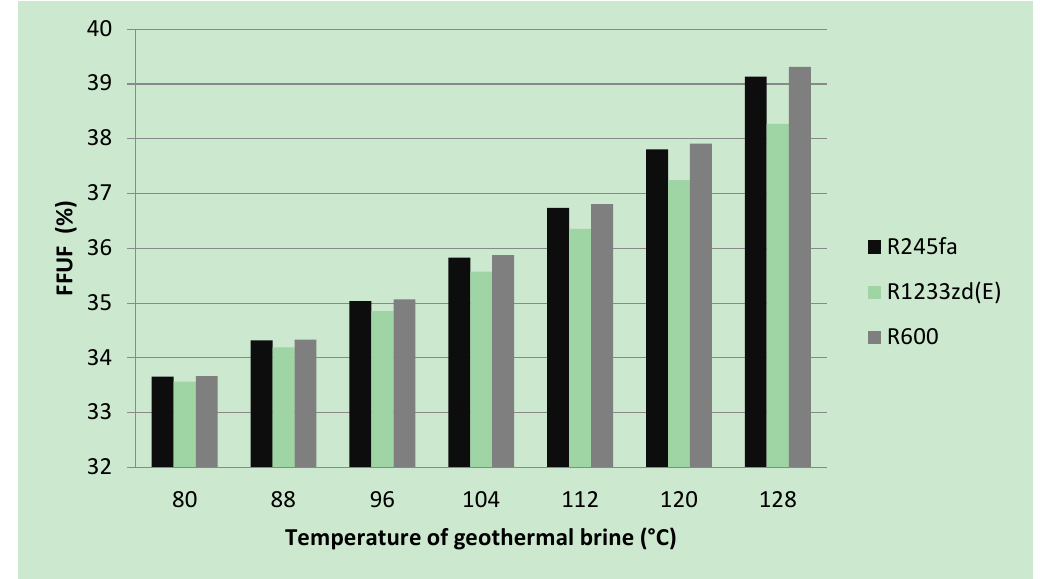
Figure 5. The fossil fuel utilization factor (FFUF) of the modified ORC system (assisted by gas turbine) as a function of the geothermal brine temperature.